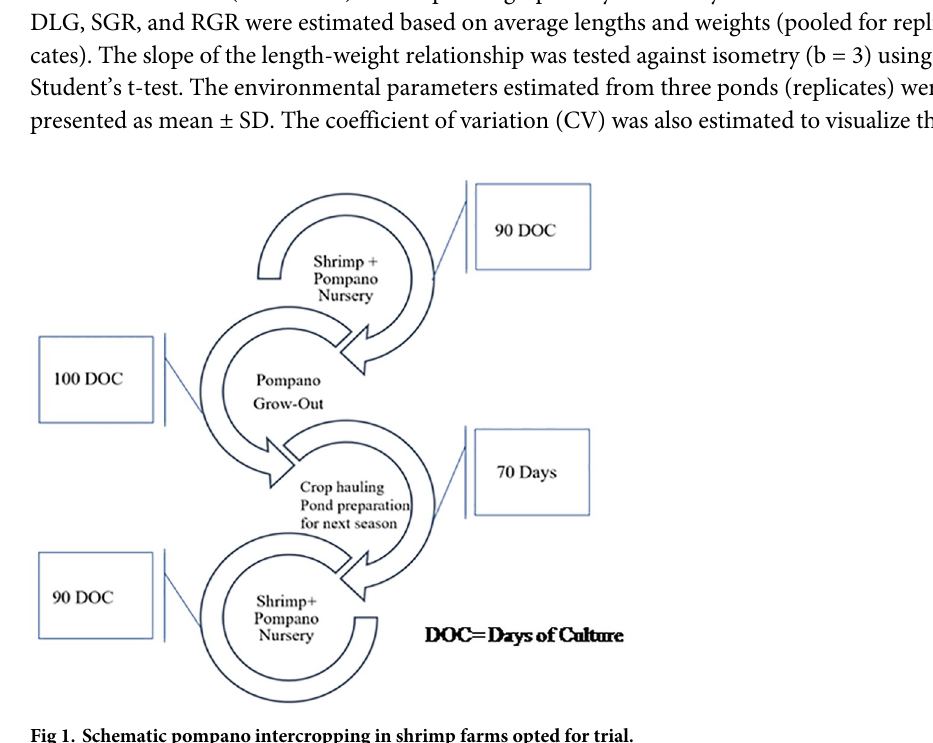
Fig 1. Schematic pompano intercropping in shrimp farms opted for